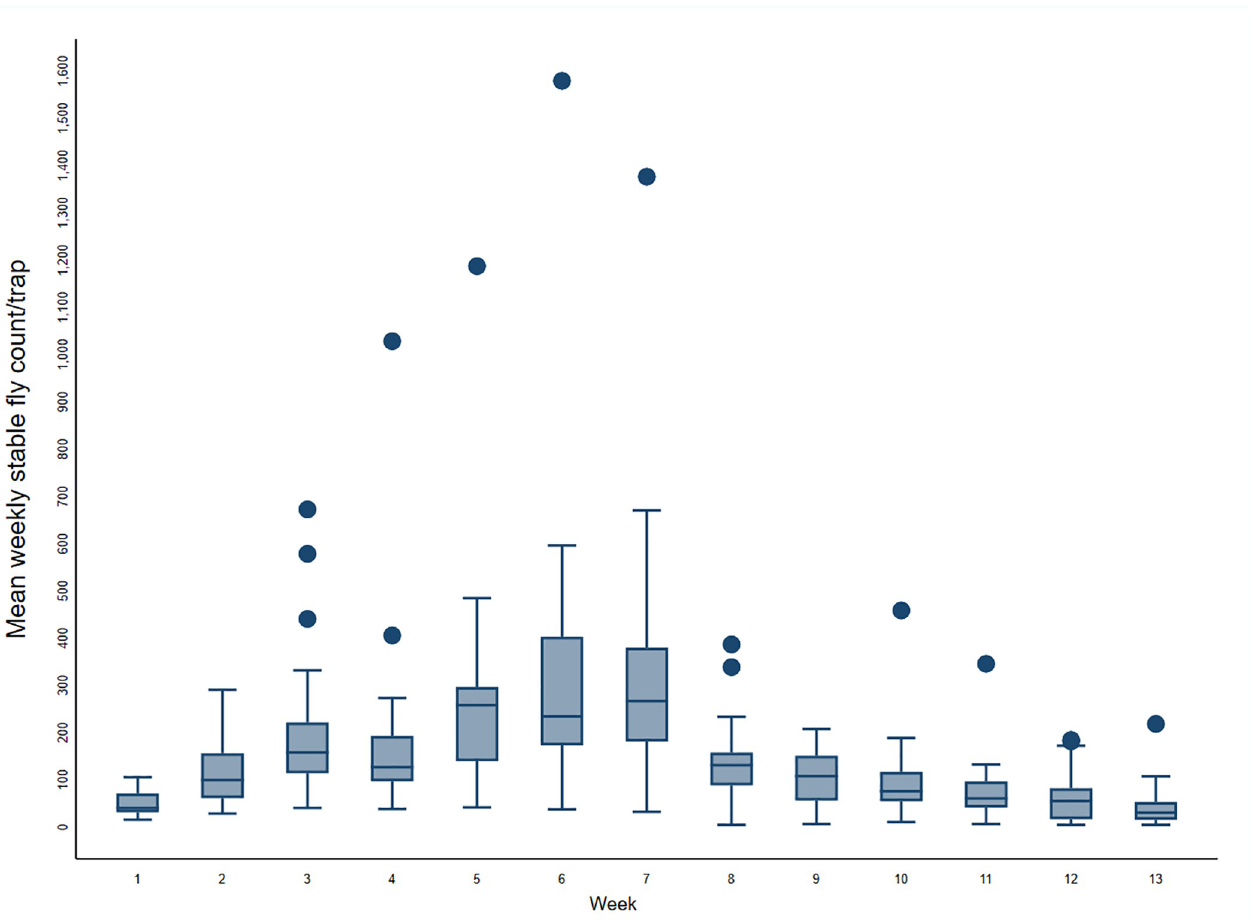
Fig 2. Boxplot of the mean weekly stable fly trap counts using five Alsynite traps on each of 20 study dairies over 13 weeks from May1st to July 31st, 2017. The upper and lower horizontal lines of the box represent the 25 th and 75 th percentiles respectively, the horizontal midline represents the median, the upper and lower horizontal whiskers lines are the upper and lower limits, and the dots are the